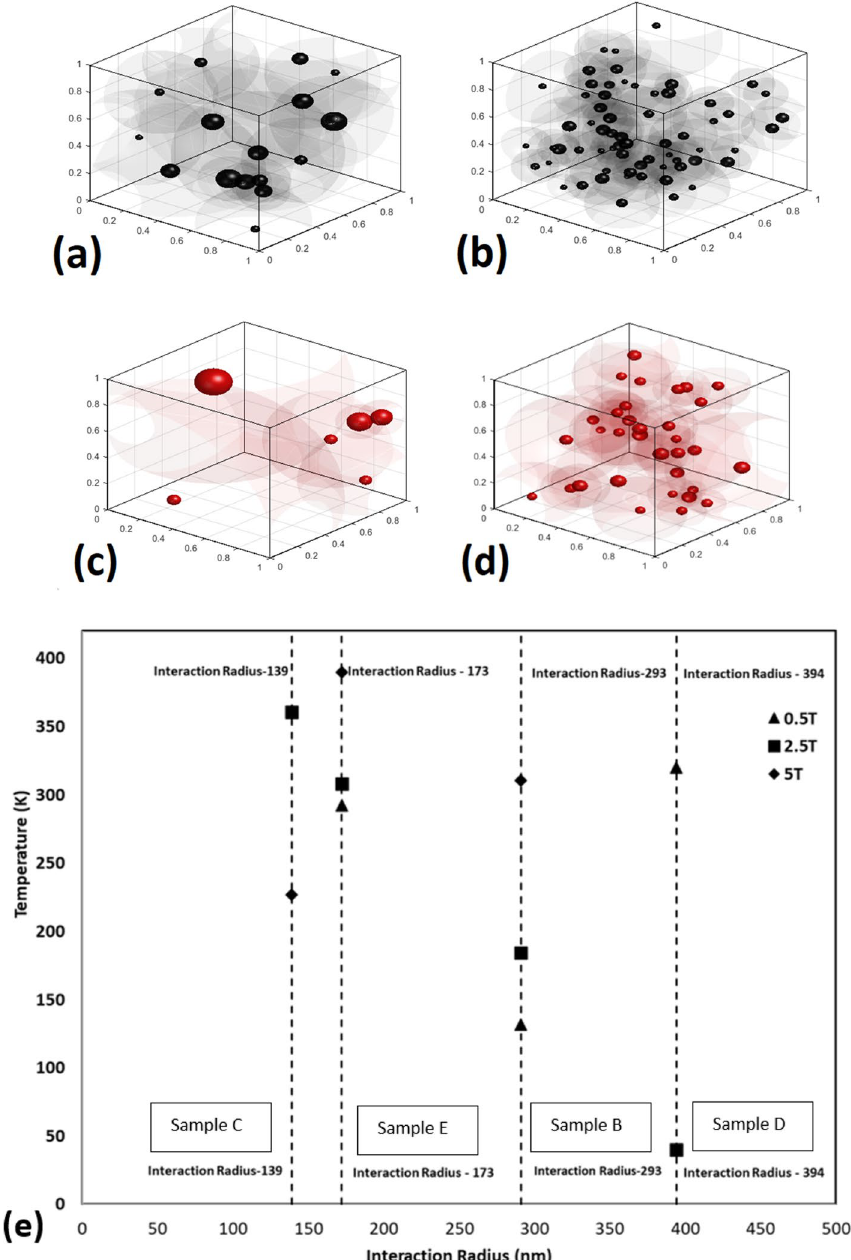
Figure 6. Simulated representation included with the interaction radius (IR) of the individual nanoparticle/ agglomerates present in the synthesized nanocomposite (1 μm 3 ) for Fe 3 O 4 samples ( a ) sample B, ( b ) sample C and superparamagnetic samples ( c ) sample D, ( d ) sample E, respectively (herein, black spheres represent Fe 3 O 4 and red spheres are for superparamagnetic nanoparticle/agglomerates, respectively.) ( e ) Correlation between blocking temperature and interaction radius of the SHMNP